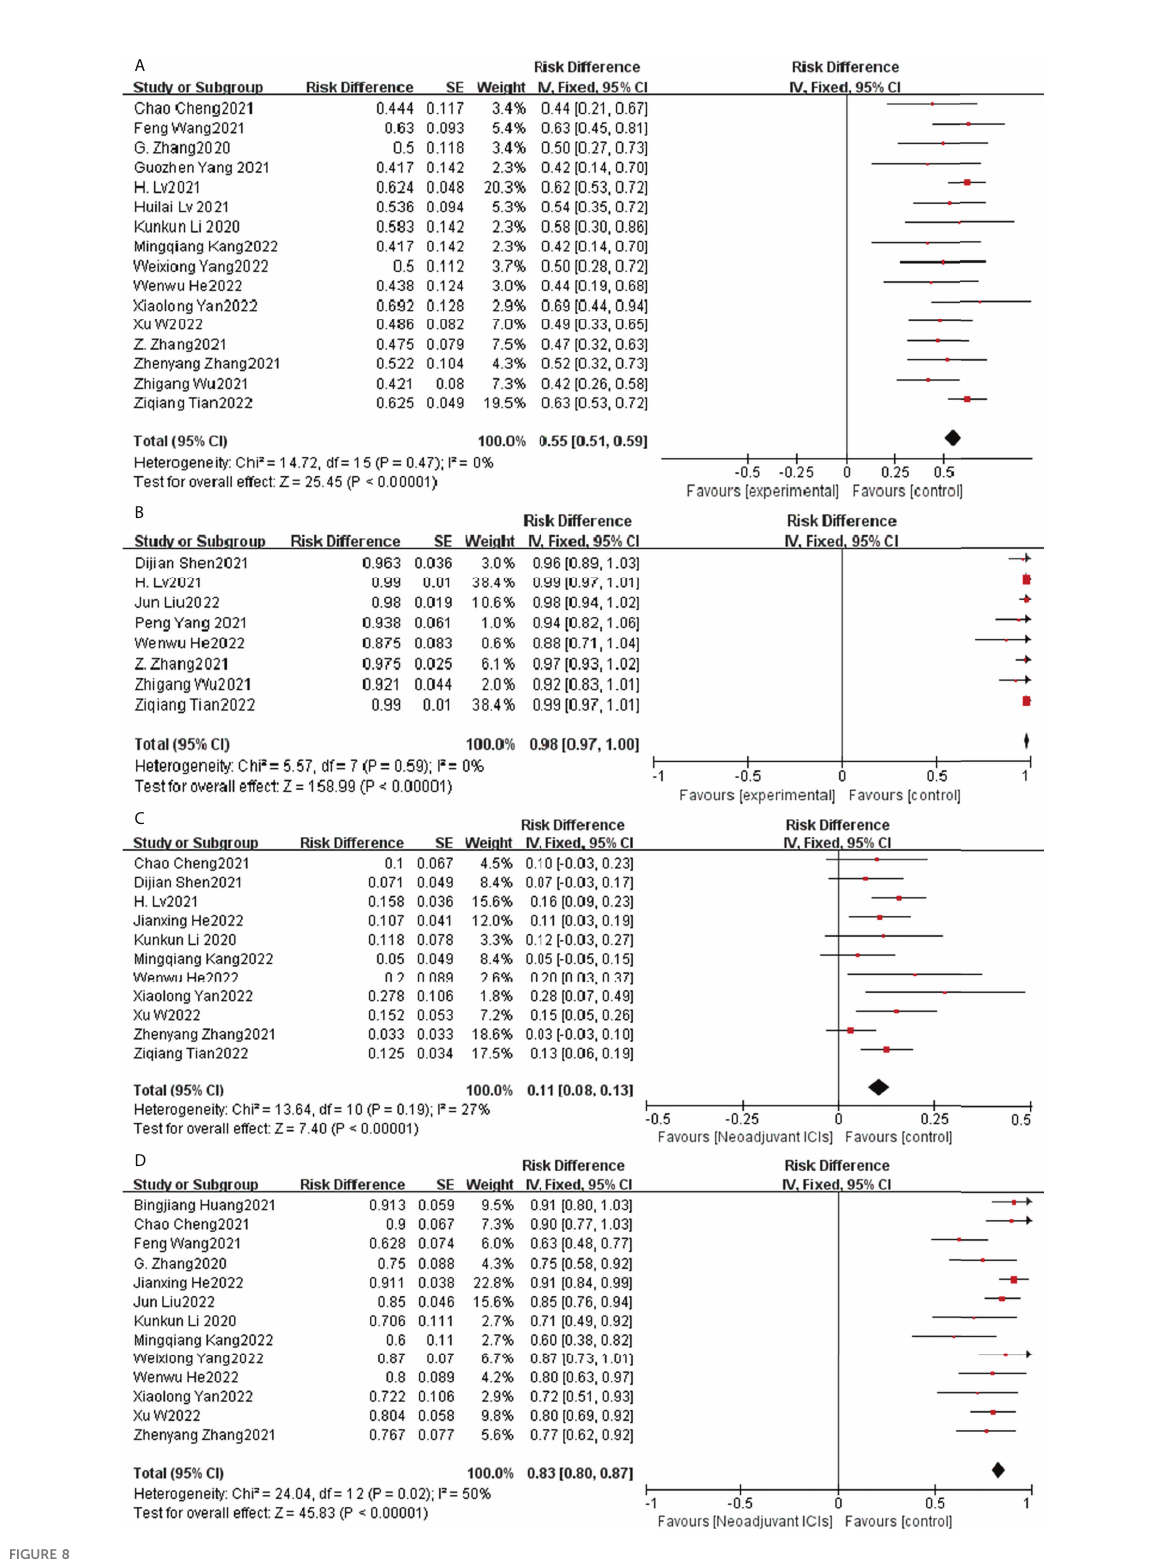
FIGURE 8 Sensitivity analysis of the incidence of MPR (A) , R0 resection rates (B) , TRAEs (C) , surgical resection rate (D)